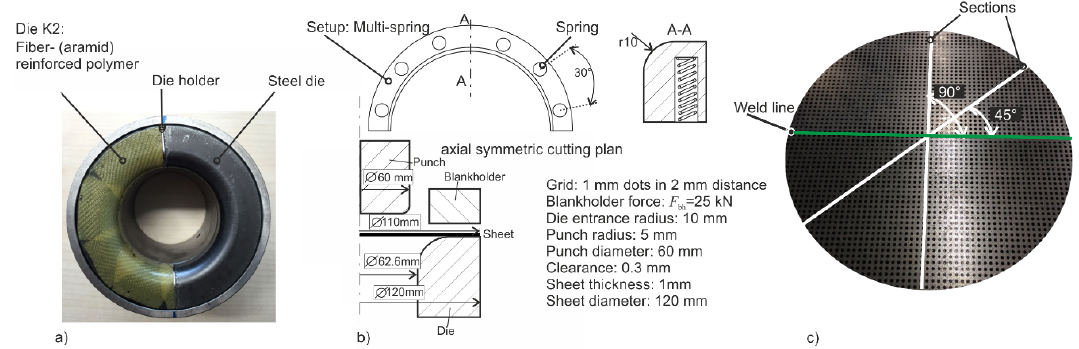
Figure 2. ( a ) Segmented die setup with steel and reinforced polymer type K2; ( b ) spring ‐ reinforced die setups and axial symmetric cutting plan; ( c ) screen ‐ printed grid on initial tailored blank with sections in two orientations related to the weld line.